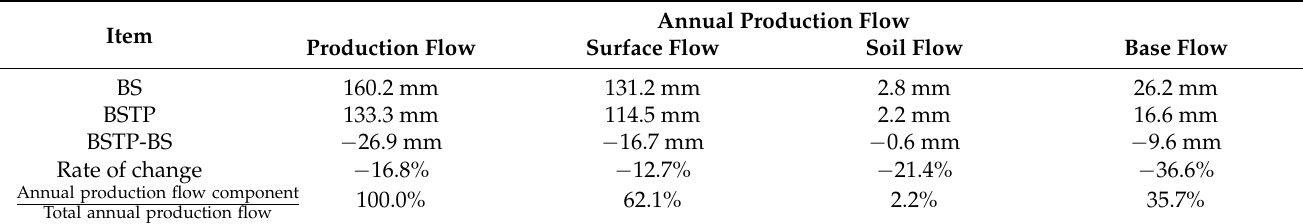
Table 6. Annual production flow influenced by climate change.